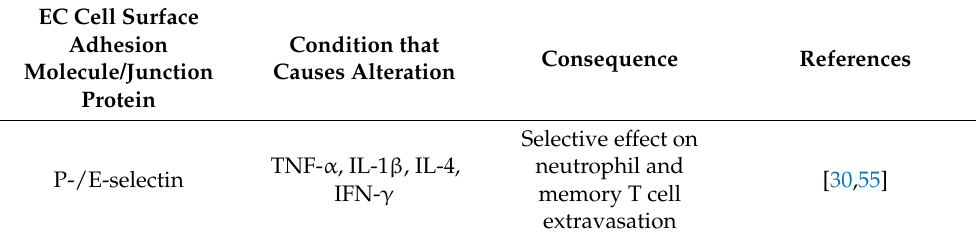
Table 1. Summary of findings described in the text in relation to EC expression of cell surface adhesion molecules, local cytokine/chemokine conditions, consequences on IC extravasation and relevant